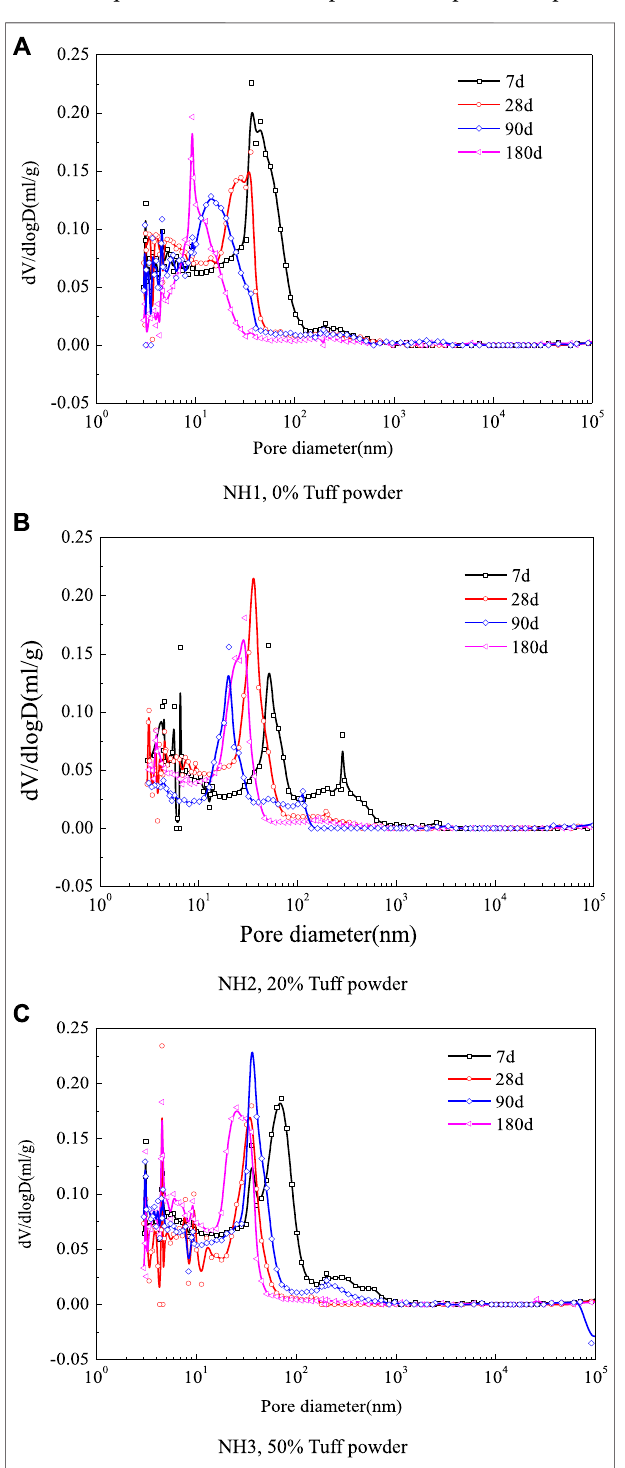
FIGURE 6 | The changes of critical pore size with curing age and the amount of tuff